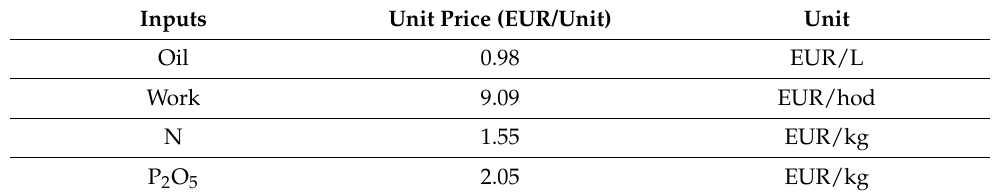
Table A2. Used unit costs of